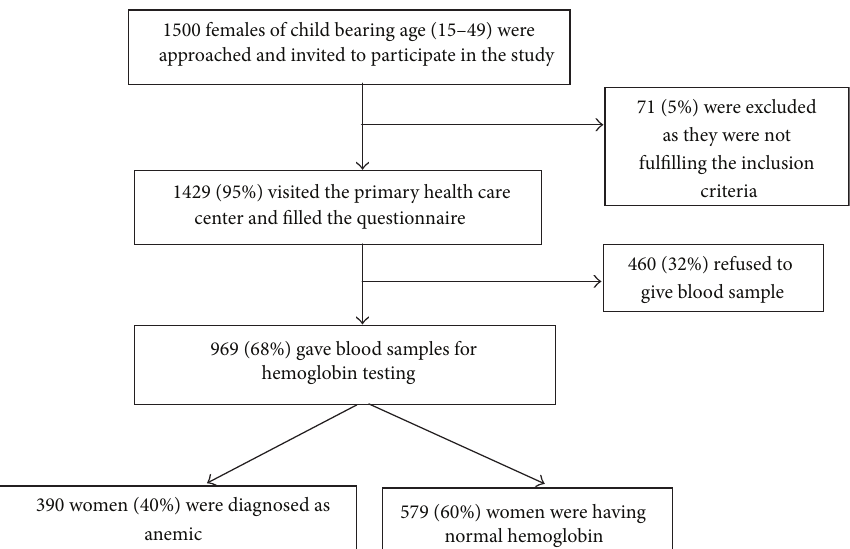
Figure 1: Enrollment flow chart of child bearing age women in Riyadh, Saudi